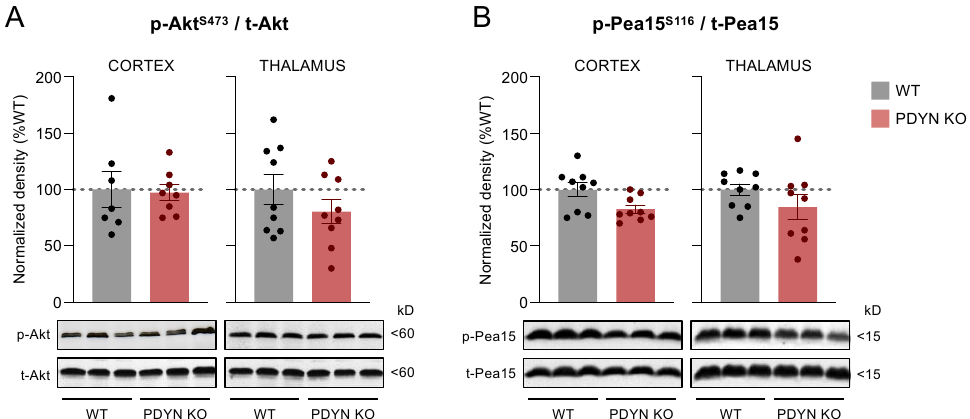
Figure 3. Immunodensities of activated ( A ) Akt and ( B ) Pea15 in cortical and thalamic brain tissue samples from WT (grey bars; n = 9) and PDYN-KO (reddish bars; n = 9) mice. Normalized protein activation was estimated as the ratio between phosphorylated (i.e., p-Ser473 Akt or p-Ser116 Pea15) to non-phosphorylated protein species. Columns are means ± SEM of each experimental group and expressed in percent change from WT animals for each brain region. ( A , B ) Representative immunoblots of cortical and thalamic Akt and Pea15 phosphorylated and non-phosphorylated species (three different animals per group) are shown at the bottom. The indicated molecular weights (in kDaltons, kDa) of the immunoreactive bands were estimated from in-gel-loaded, prestained protein standards.